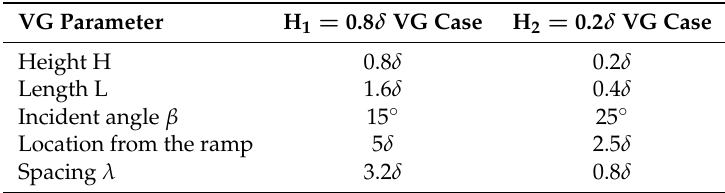
Table 1. Vortex generator geometry and parameters corresponding to the vane-type VG cases of